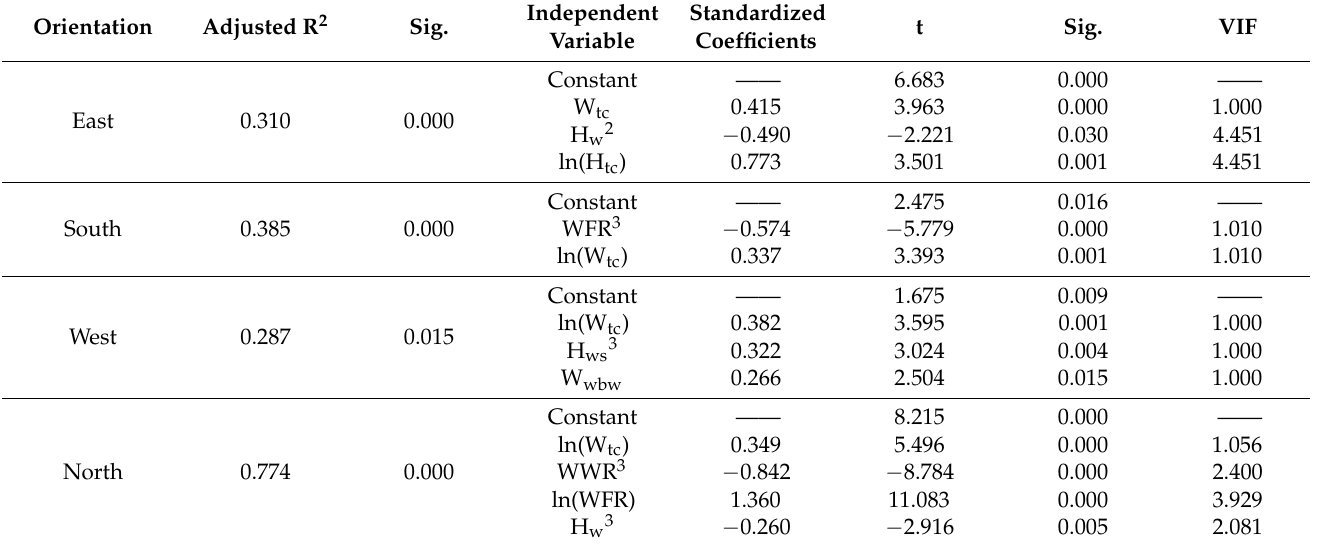
Table 4. Comprehensive analysis results of multiple regression models of UDI 100–2000 in differently- orientated terrace